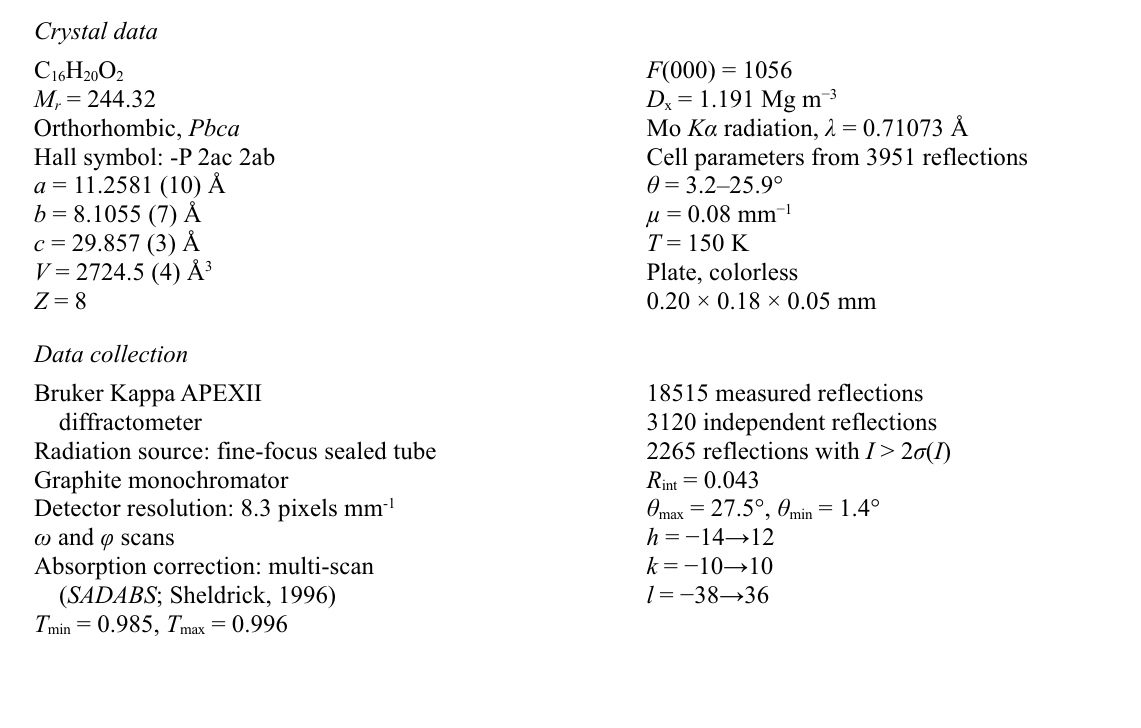
Figure 2 Hydrogen bonded dimer. Dashed lines represent hydrogen bonds. [Symmetry code: #1 - x + 1, - y , - z + 1.] 2,6-Dimethyl-4- m -tolylcyclohex-3-enecarboxylic acid Crystal